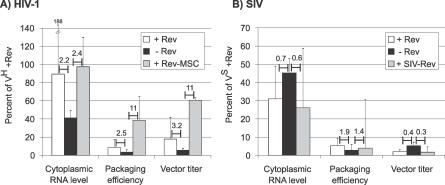
Relevance of the Rev–RRE Interaction(A) An HIV-1 vector plasmid in which stem loop II of the RRE was replaced by the MS2 stem loop was cotransfected with expression plasmids for HIV-1 gag-pol, VSV-G, and tat in the absence (−Rev) or presence of a rev (+Rev) expression plasmid, or in the presence of an expression plasmid encoding a fusion protein of Rev and the MS2 coat protein (+Rev-MSC). (B) An SIV vector with a deletion (VSΔSL in Figure 1B) of stem loop II of the RRE was cotransfected with expression plasmids for SIV gag-pol, VSV-G, and tat in the absence (−Rev) or presence of an HIV-1 (+Rev) or SIV rev expression plasmid. Cytoplasmic RNA levels, packaging efficiency, and vector titers were determined as described, and all values are expressed relative to the values obtained in the same transfection experiment for the parental VH (A) and VS (B) vectors in the presence of Rev, which were set as 100%.Mean value and standard deviation of at least three independent transfection experiments are shown. Numbers above the short vertical lines indicate fold induction by Rev.